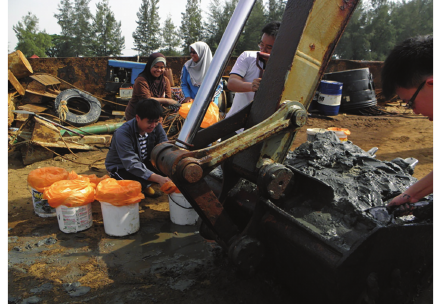
Figure 1: Sample collection from the backhoe